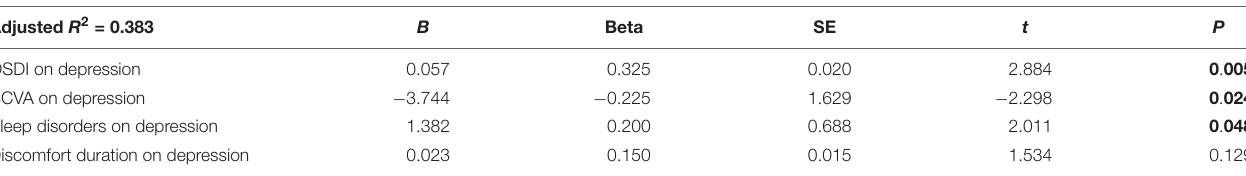
TABLE 9 | Multiple linear regression analysis of association between depression scores, demographic and dry eye parameters in patients aged 20-40. Adjusted R 2 =